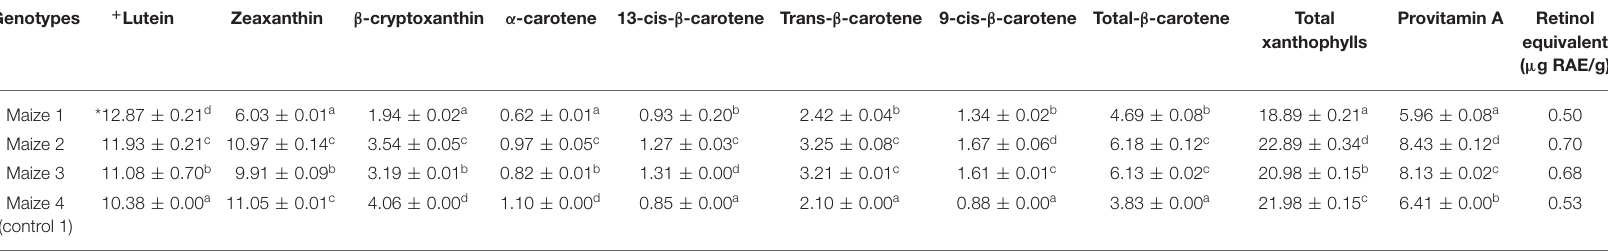
TABLE 3 | Carotenoid ( µ gg − 1 ) profile and retinol activity equivalent of maize flour from provitamin A maize genotypes and yellow maize (dry weight basis). Genotypes